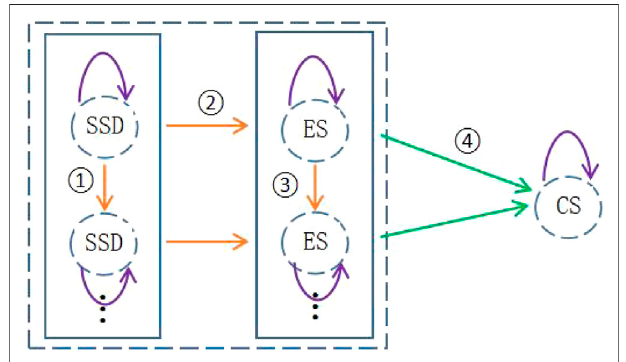
FIGURE 2 | Task scheduling model for cloud-edge collaboration and multinode cluster collaborative computing.